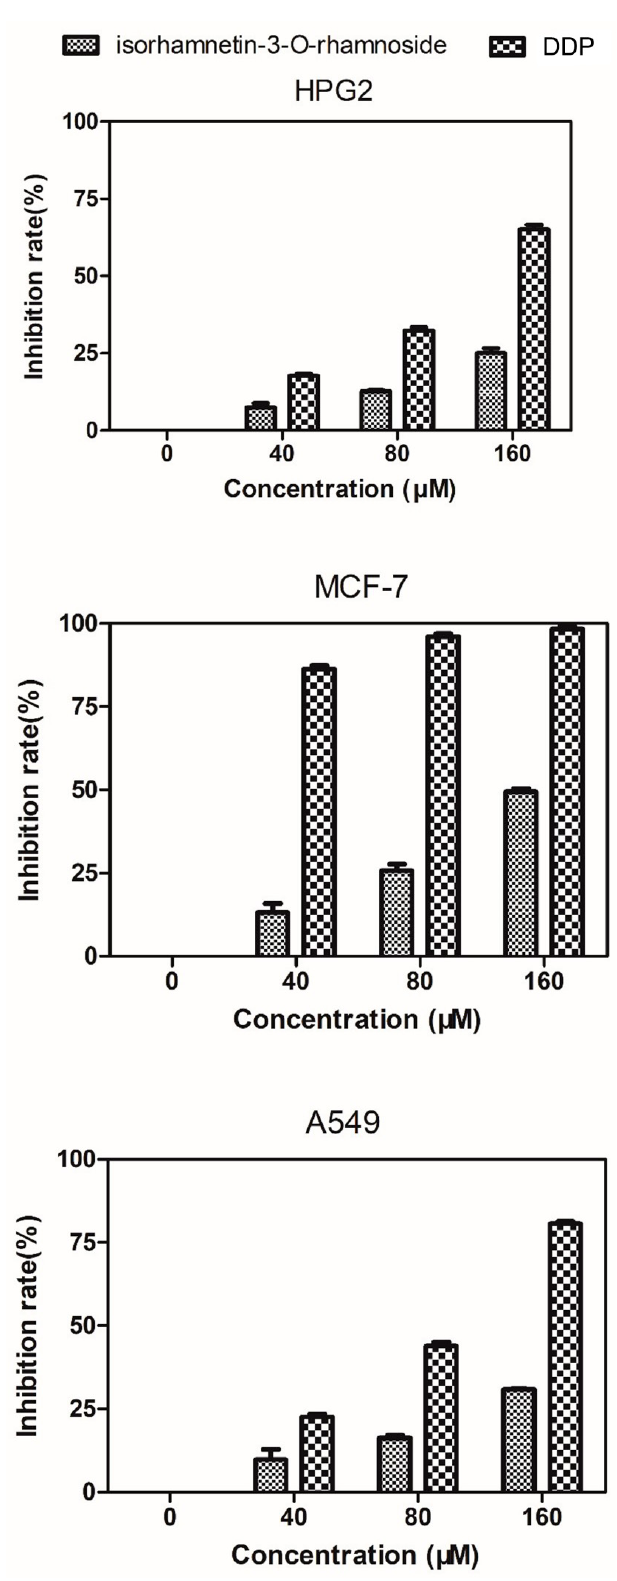
Figure 9. Isorhamnetin-3- O -rhamnoside evaluation of cytotoxicity against HepG2, MCF-7, and A549 cells. Various concentrations of Isorhamnetin-3- O -rhamnoside and DDP (0, 40, 80, or 160 µ M) were